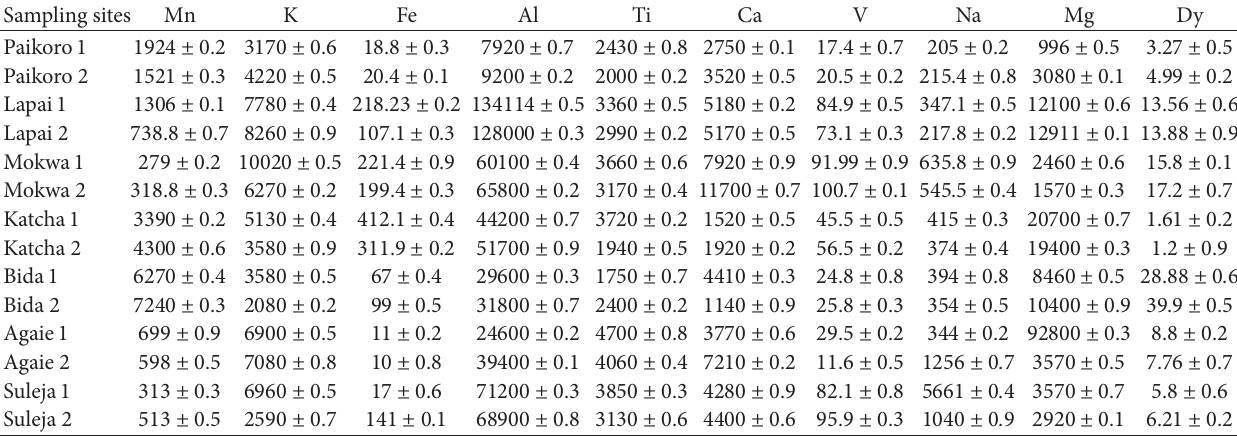
Table 5: Elemental concentration in the soil samples for plants growth.